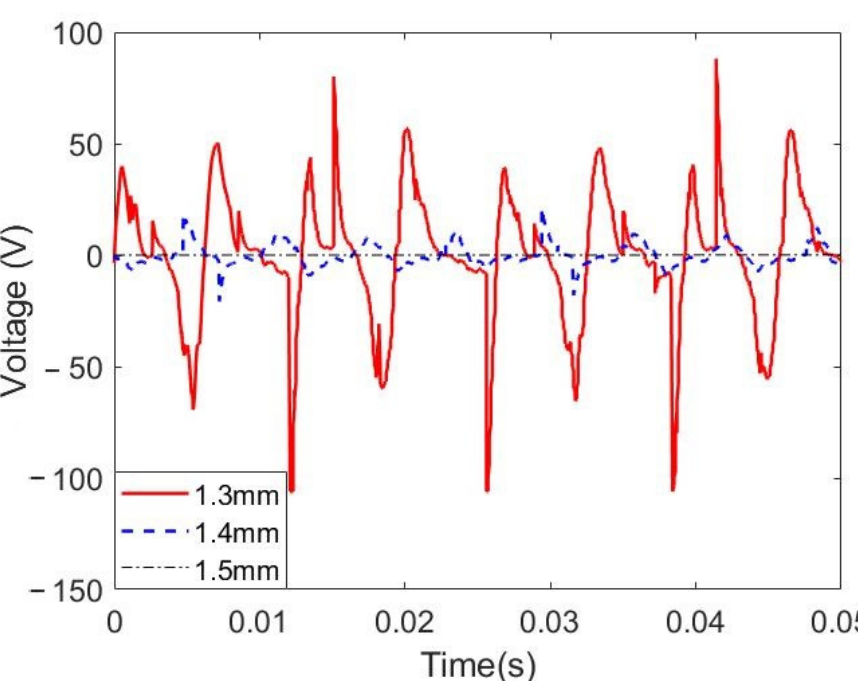
Figure 4. Optimization of the gap between rotational element and stationary element by measuring the open-circuit voltage, V oc , of the HDR-TENG. Before reaching the contact point (the gap between two dielectric materials is 1.2 mm), the output voltage of the device increases when the gap is reduced from 1.5 mm to 1.3 mm and reaches the maximum output voltage of 126.63 Vpp with a gap of 1.3 mm.